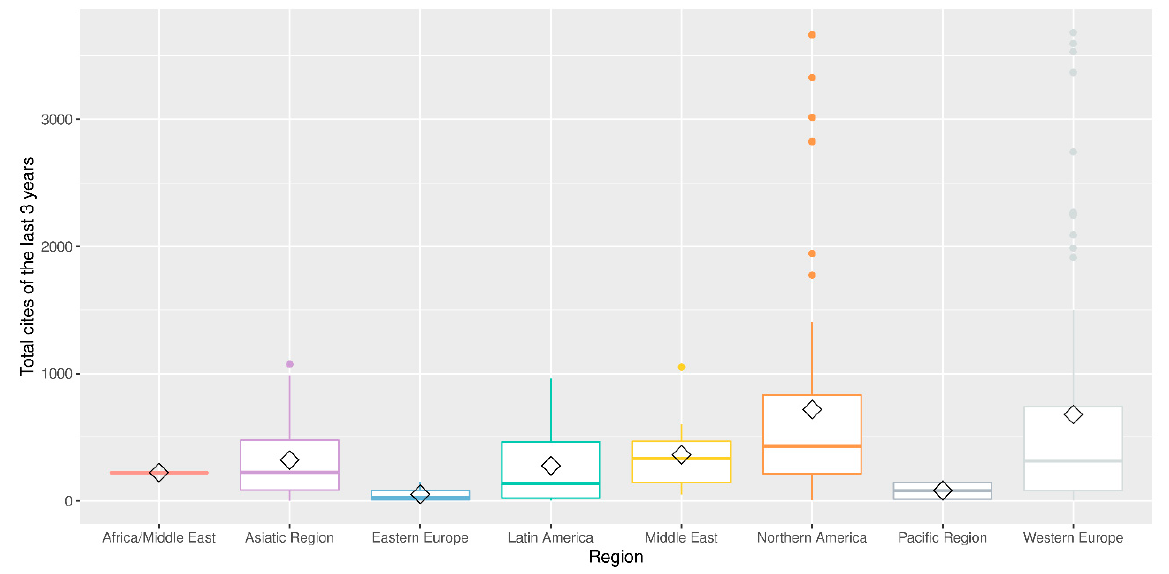
Figure 12. Global comparison of total citations between all regions.